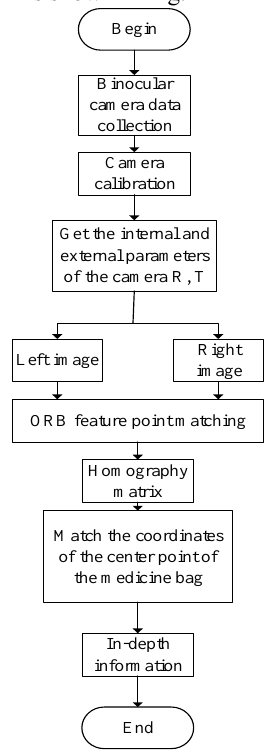
Fig. 1. Flow chart for calculating the depth of the center point of the medicine